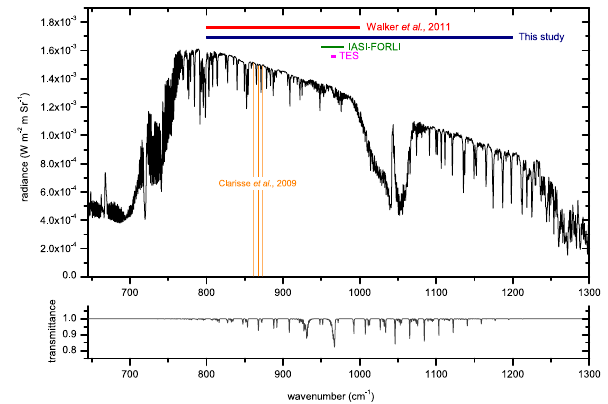
Fig. 1. Top: Example of an IASI spectra between 645 and 1300cm − 1 measured on 30 August 2011 in the California San Joaquin Valley (USA). The orange range was used for the first global NH 3 distribution obtained by satellite ( Clarisse et al., 2009), with the vertical lines representing the channels used to compute the brightness temperature difference. The green range shows the spec- tral interval used by FORLI on IASI spectra and the pink ranges the microwindows used for TES NH 3 retrievals (Shephard et al., 2011). The large red and dark blue ranges are the continuous spectral inter- vals used for the NH 3 detection in Walker et al. (2011) and in this work, respectively. Bottom: Transmittance of ν 2 vibrational band of NH 3